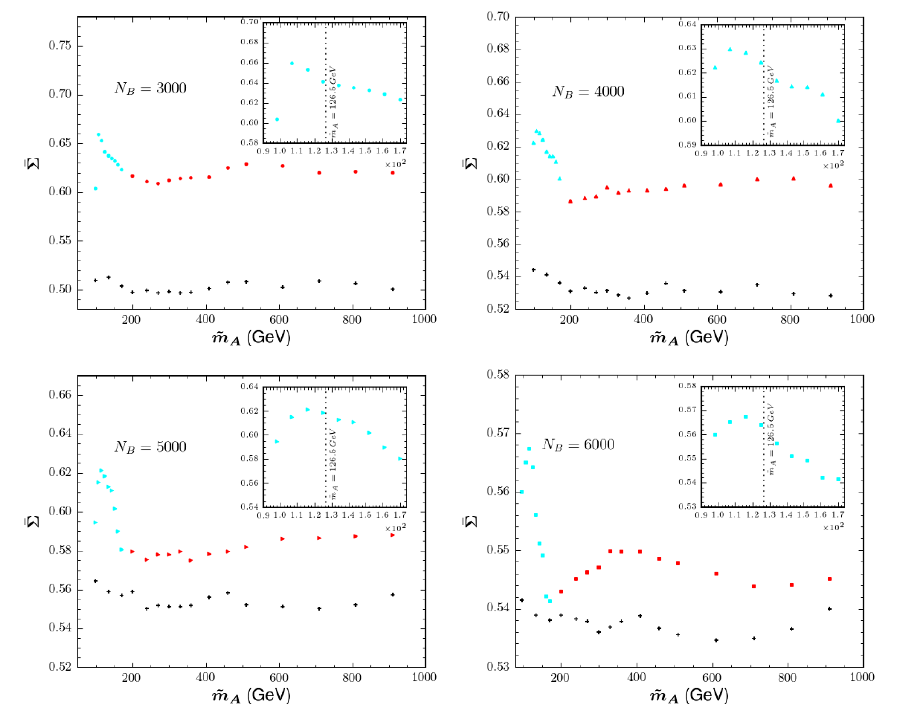
Figure 27 . The same as (cid:12)gure 25, but accounting for the detector resolution as described in the